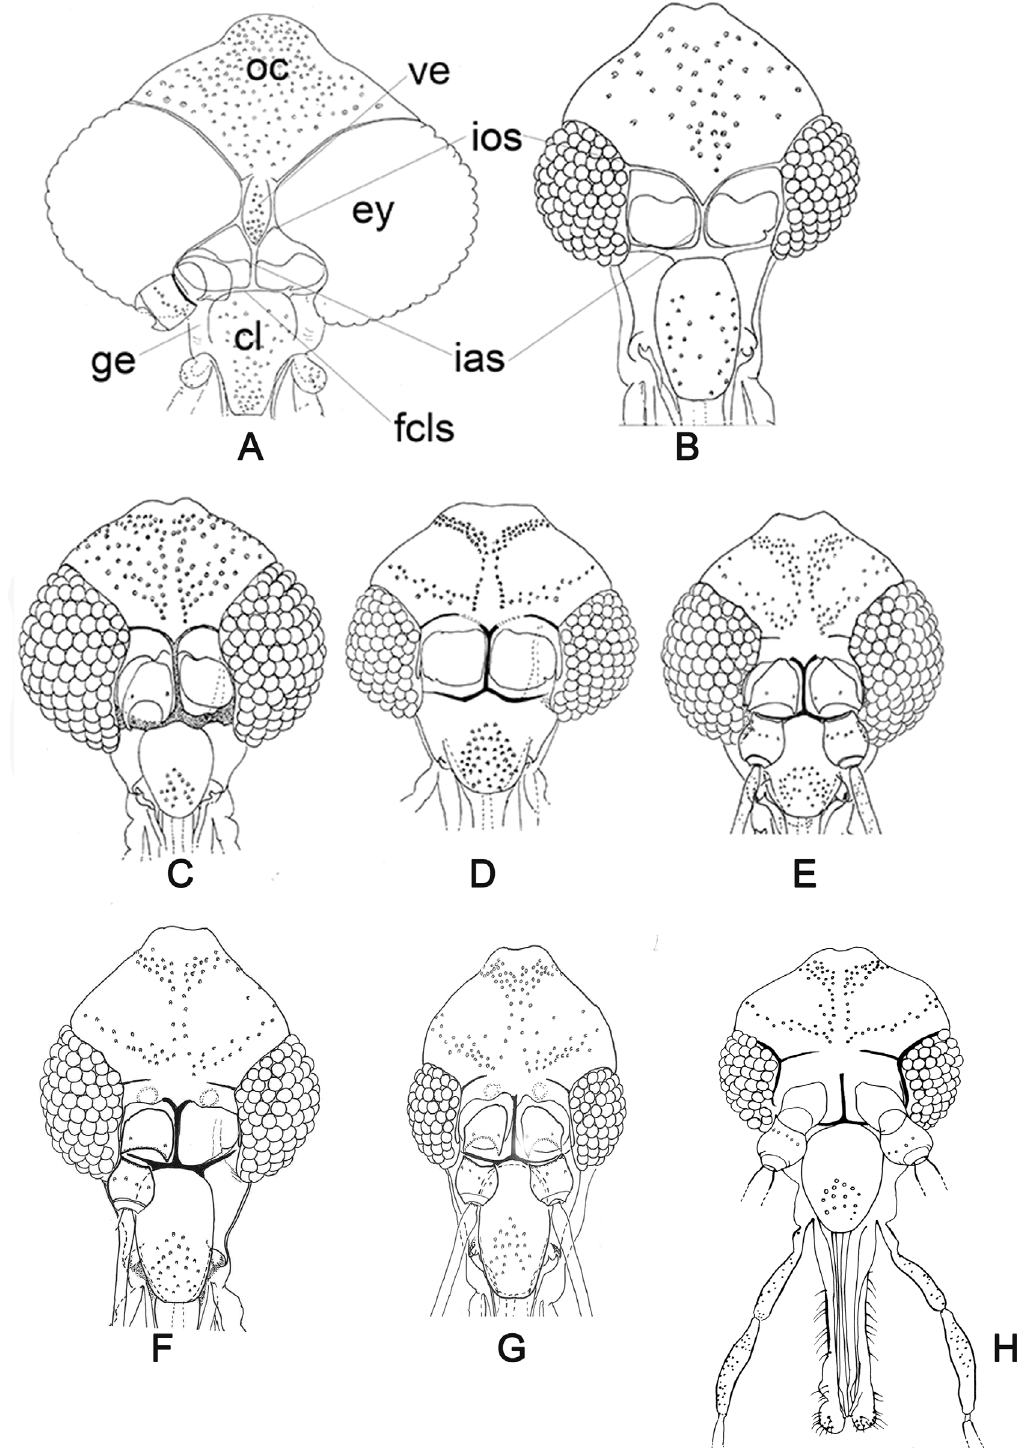
Figure 2. (A–G) Dorsal view of the head of Bruchomyiinae and Phlebotominae with the distribution of the setae on some sclerites, the relation of clypeus to eyes and aspects of some structures (A) Bruchomyiinae ( Bruchomyia sp. ). (B) Phlebotominae: Warileya phlebotomanica ; (C) Brumptomyia brumpti ; (D) Sergentomyia (Sergentomyia) minuta ; (E) Pintomyia (Pifanomyia) maranonensis ; (F) Lutzomyia ( Helcocyrtomyia ) tejadai ; (G) Lu. ( Helcocyrtomyia ) blancasi ; (H) Phlebotomus ( Euphlebotomus ) barguesae . ey – eye; fcls – frontoclypeal suture; ge – gena; ias – interantennal suture; ios – interocular suture; oc – occiput; ve –